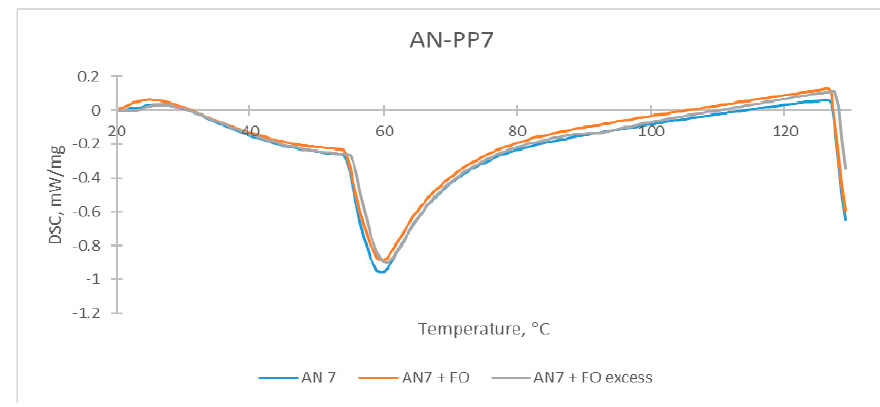
Figure 5. TG results of AN-F.